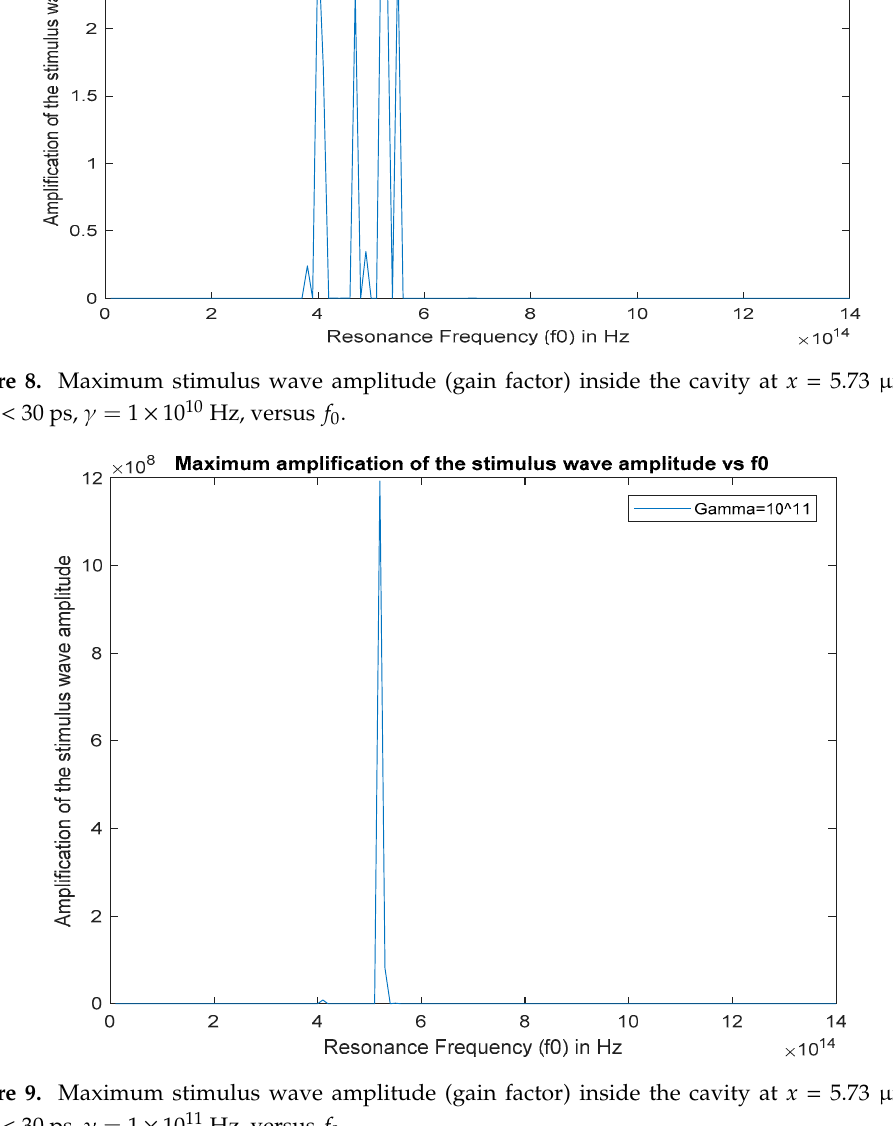
Figure 9. Maximum stimulus wave amplitude (gain factor) inside the cavity at x = 5.73 μ m for 0 < t < 30 ps, 𝛾 = 1 × 10 (cid:2869)(cid:2869) Hz , versus 𝑓 (cid:2868) .